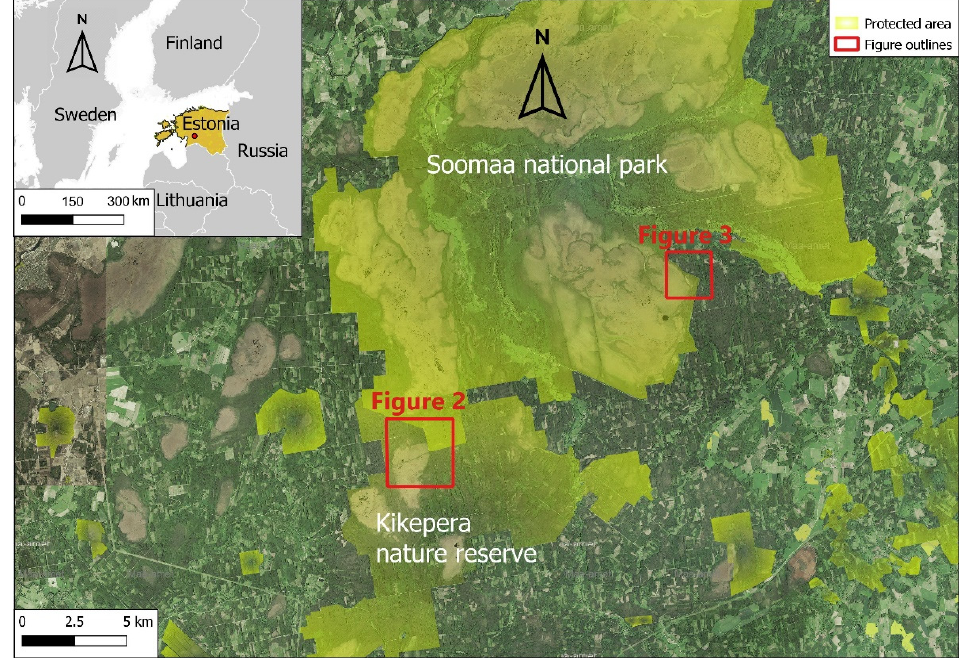
Figure 1. Location of the study area and test plots.